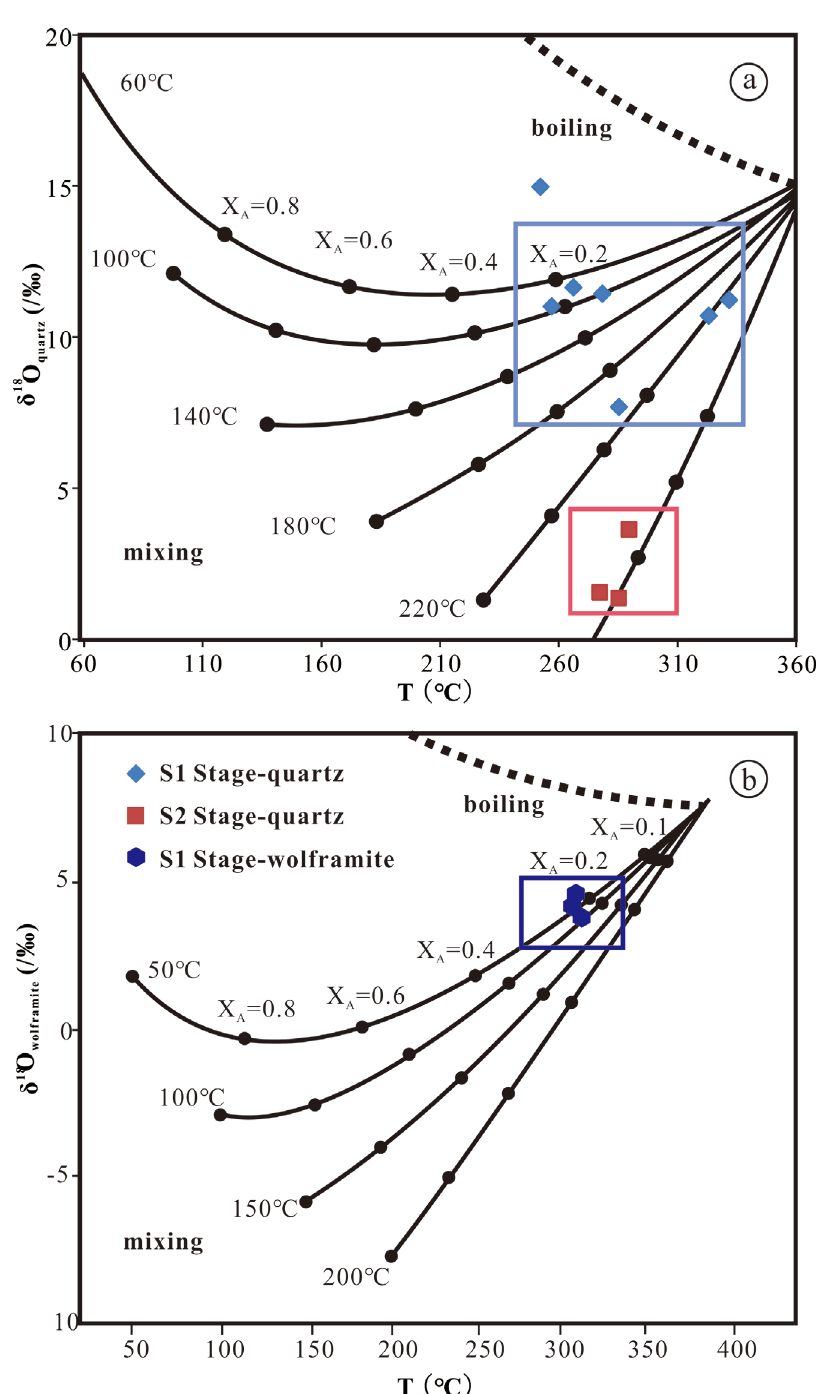
Figure 13. Effect of boiling and mixing of quartz ( a ) and precipitated wolframite ( b ) and on oxygen isotope composition at different temperatures (number X A is the mass fraction of atmospheric precipitation). Oxygen isotope trends of wolframite and quartz from [66].